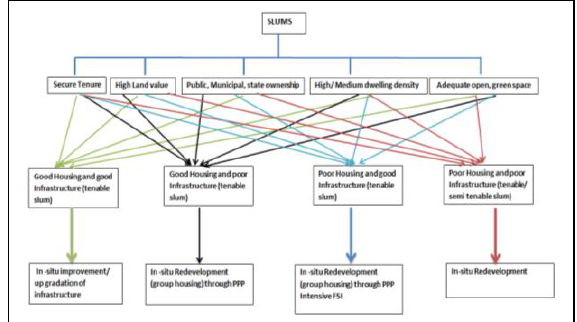
Figure 3 a Slum have secured tenure for Improvement and Upgradation